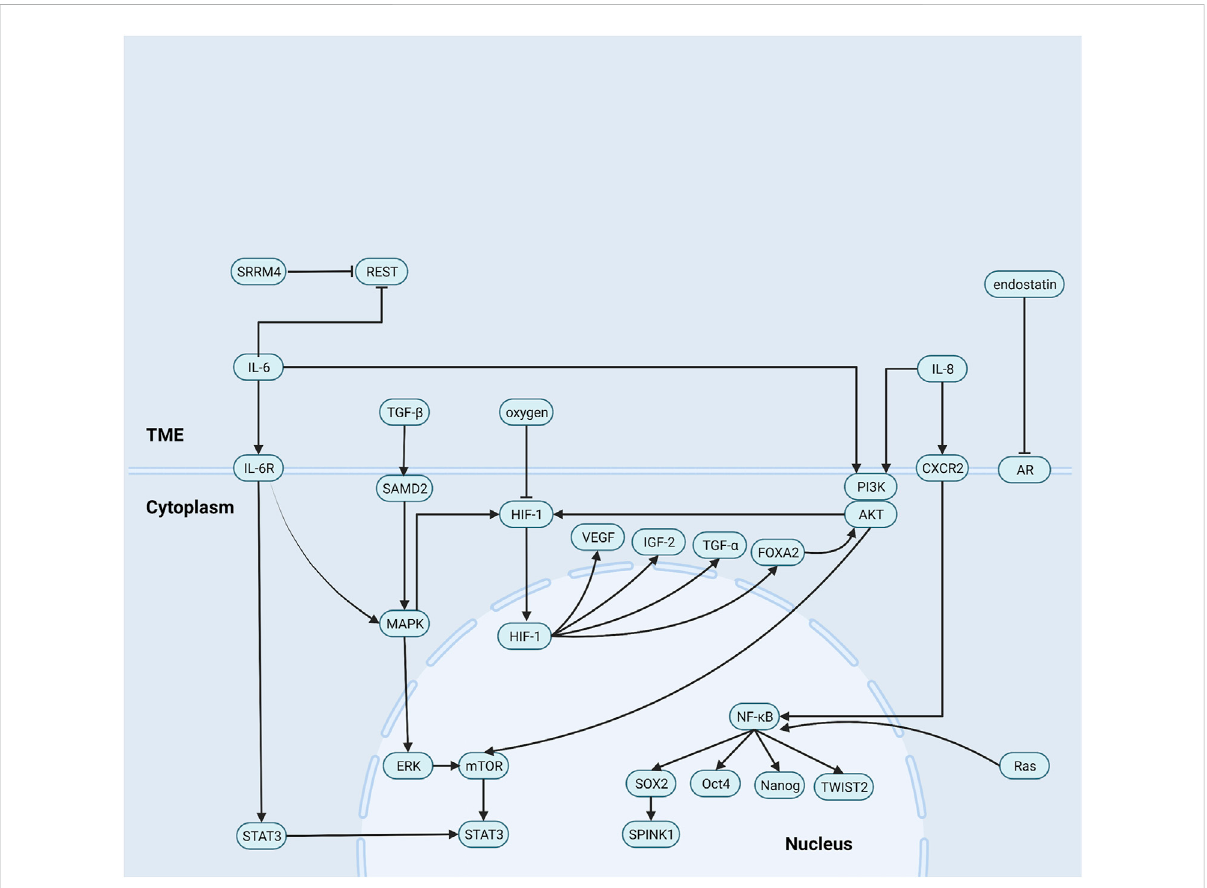
FIGURE 1 Role of non-cellular components in the NEPC microenvironment. (1) IL-8 activates NF- κ B pathway signaling to increase levels of a series of stem cell transcription factors expression. (2) IL-6 induces neuroendocrine prostate cancer formation by activating STAT3 and MAPK/ERK signaling, andreducingtheREST. Besides, IL-8andIL-6upregulateHIF-1viaPI3K/AKT/HIF-1 α pathway andMAPK/HIF-1 α pathway.(3)TGF- β /SMAD2 pathway signaling activates p38 MAPK and then induces neuroendocrine differentiation. (4) endostatin blocks androgen receptor signaling and then promotes the formation of epithelial tumor cells into androgen-independent